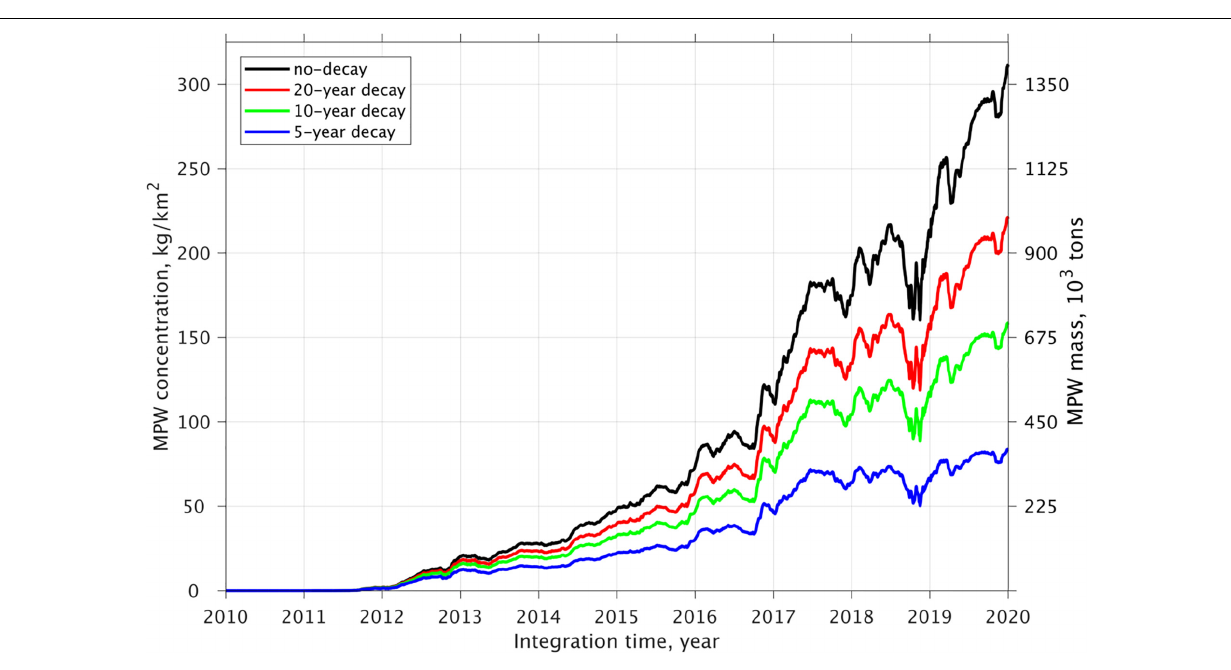
Frontiers in Marine Science |